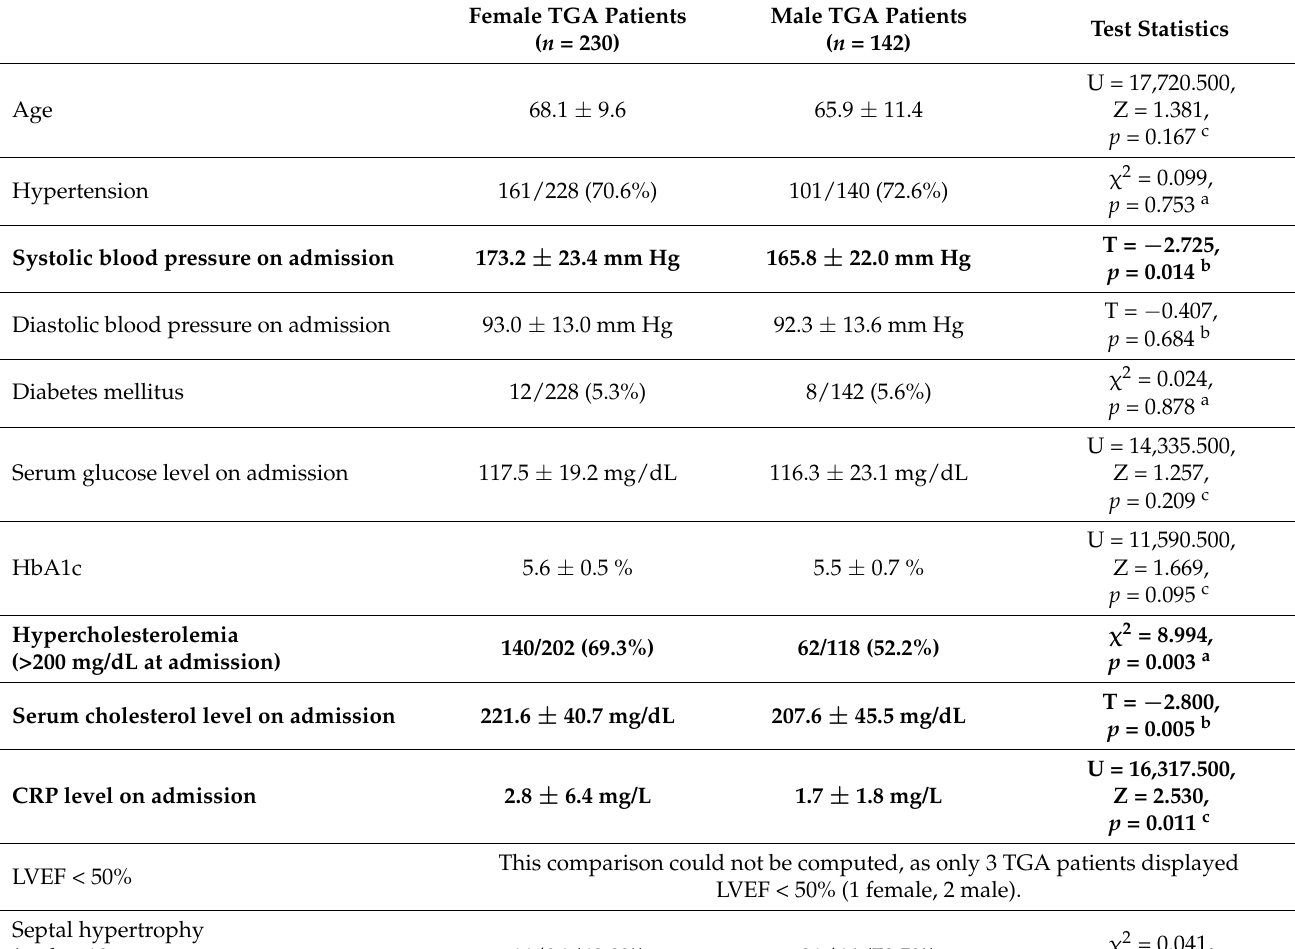
Table 1. Sex-specific comparisons of TGA patients ( n =